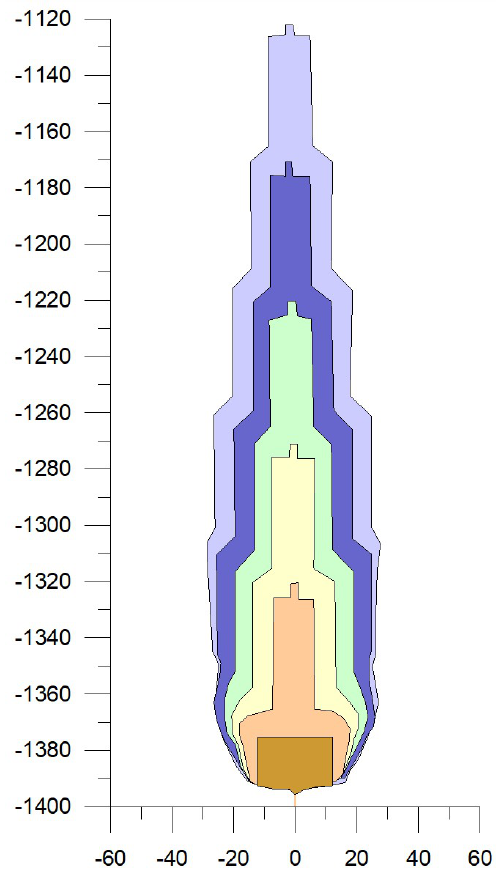
Figure 1. Six steps of salt cavern development applying roof-side leaching method. Zones that are marked in the same color are simultaneously leached